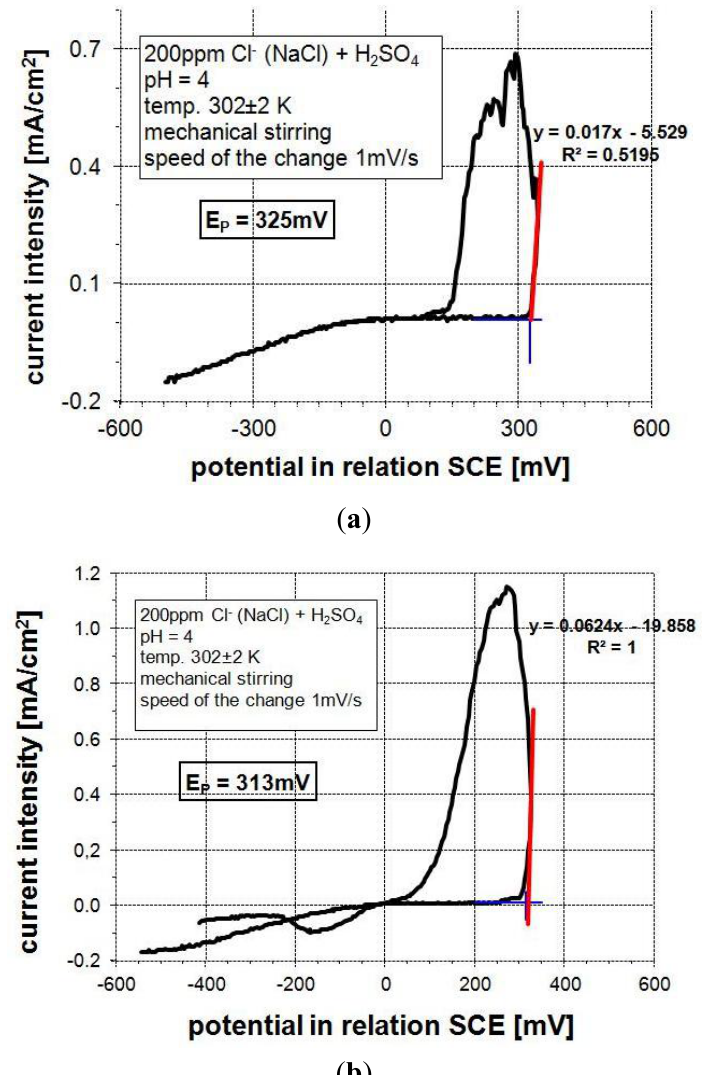
Figure 8. Anodic cyclic polarization curves for bulk materials at the following experimental conditions: 200 ppm NaCl + H 2 SO 4 , pH = 10, t = 302 ± 2 K, mechanical stirring, potential change rate—1 mV/s; ( a ) alloying cast with Fe 3 Al matrix with